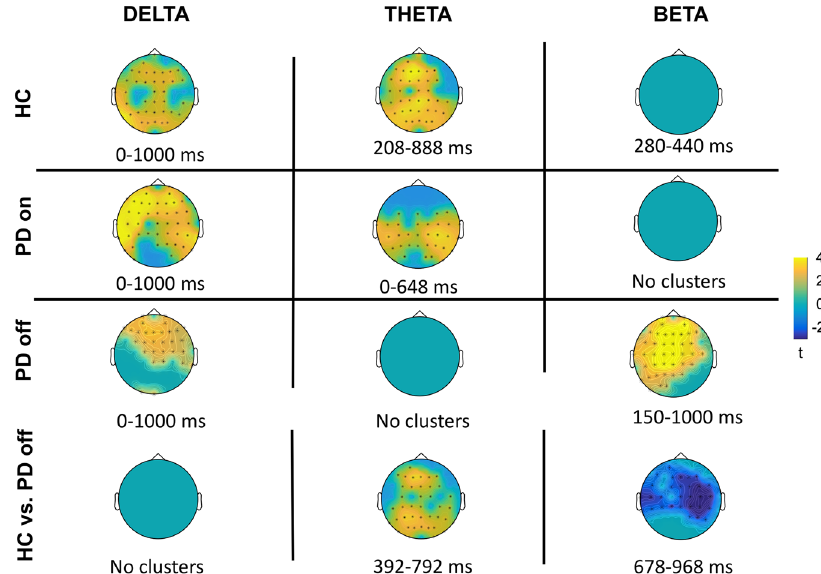
Fig. 5 Cluster-based permutation in the TF domain for each group. Scalp representation of the cluster-based permutation (dependent sample t -test with cluster-correction at p < 0.05) of incorrect vs correct action. For each frequency and group, the topography shows the time- point at which the cluster reached the maximal spatial extension in the interval of interest. The intervals with a signi fi cant effect are shown below the topography. The bottom line shows cluster-based comparisons of the differential activity (incorrect minus correct) in the frequency bands of interest between HCs and off-condition PD; only intervals with signi fi cant clusters are